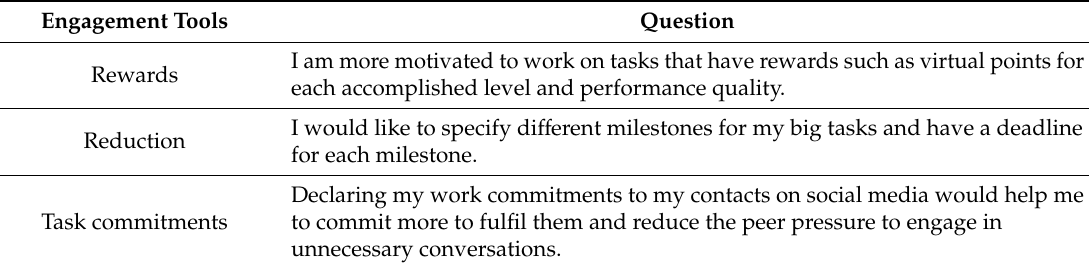
Table 5. Task engagement